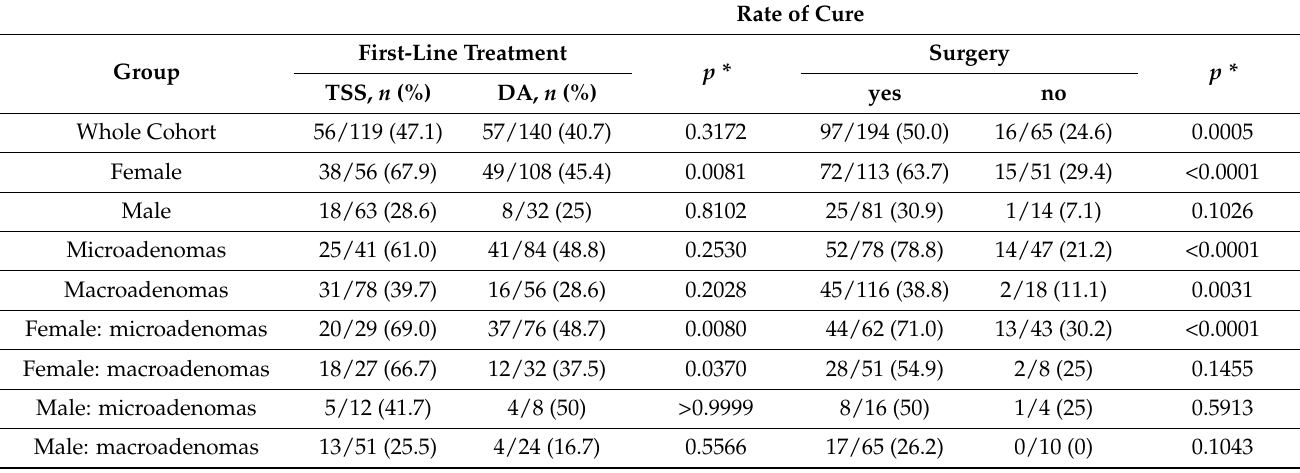
Table 2. Rate of a cure depending on the first-line treatment and surgery in the whole cohort.